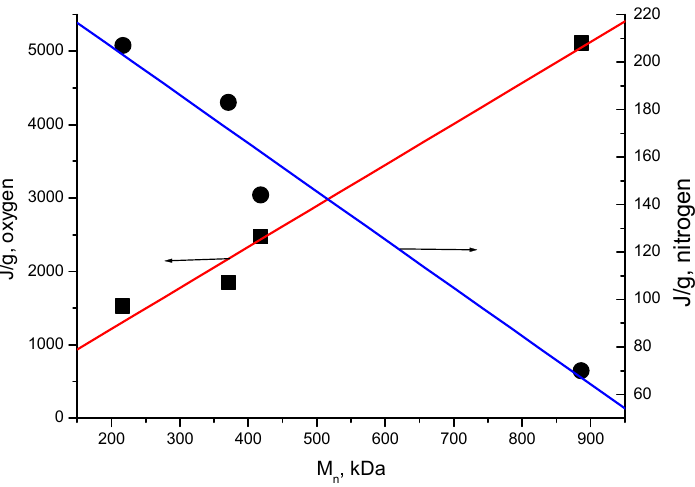
Figure 10. The surface below the DSC exotherms for oxygen (squares) and nitrogen (circles) experiments plotted vs. molar mass of respective samples.